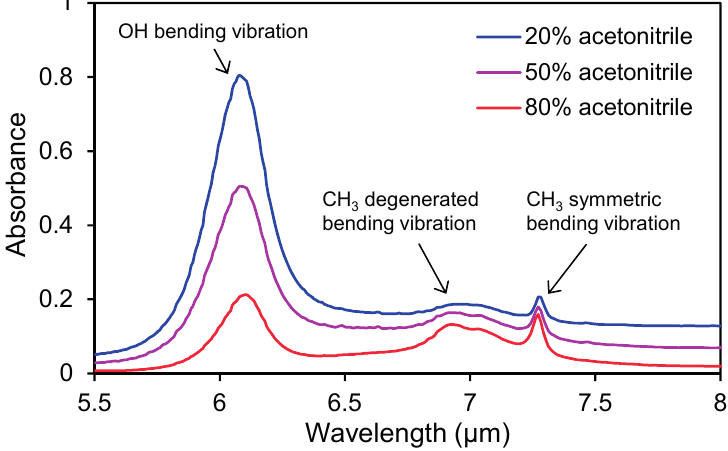
Figure 3. IR absorption spectra of the acetonitrile mixture used in reversed-phase liquid chromatography.